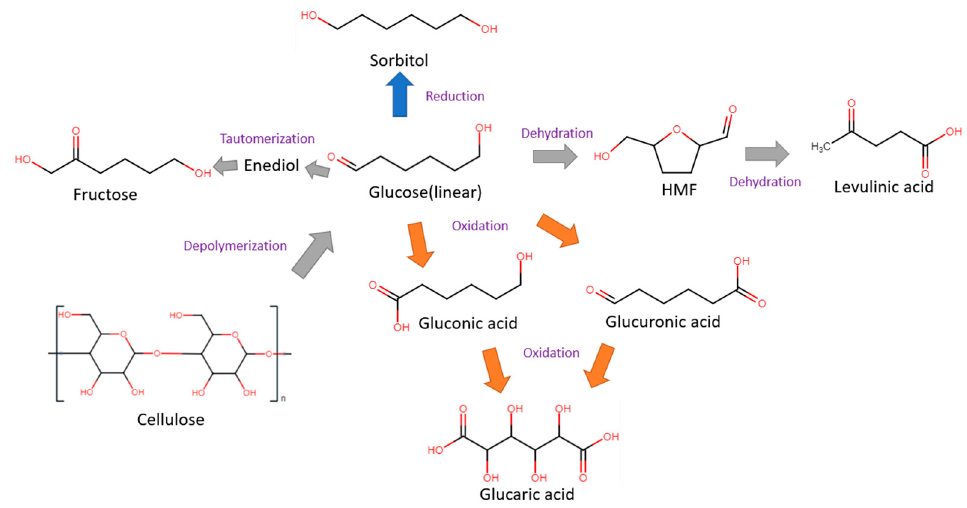
Figure 2. Cellulose, glucose and its derivatives.